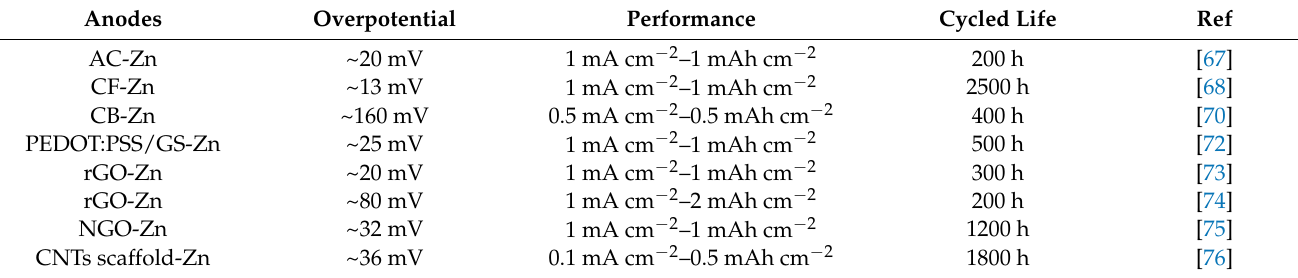
Table 1. Carbon-based coating materials for improving Zn metal